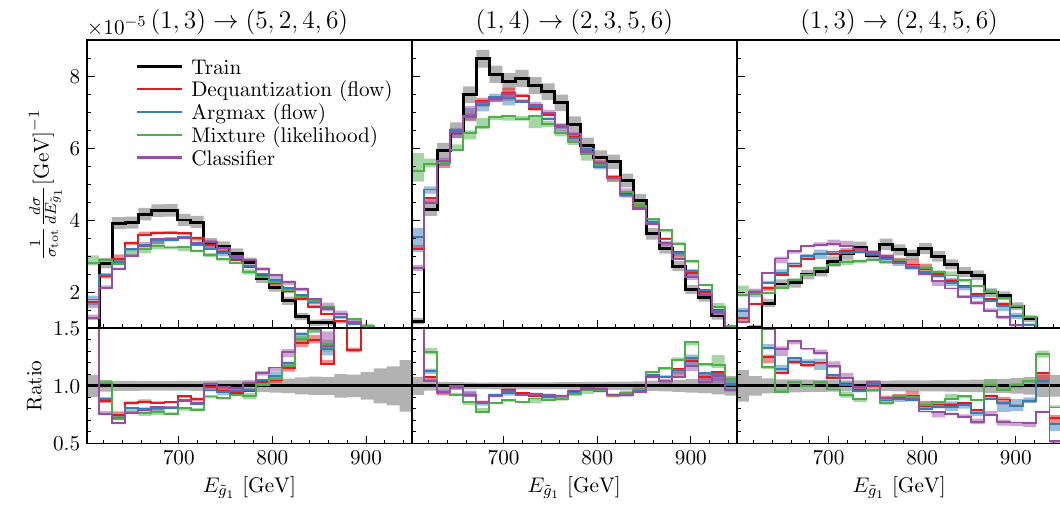
Figure 13: The gluino energy spectra of a selection of colour orderings as predicted by the same models as in figure